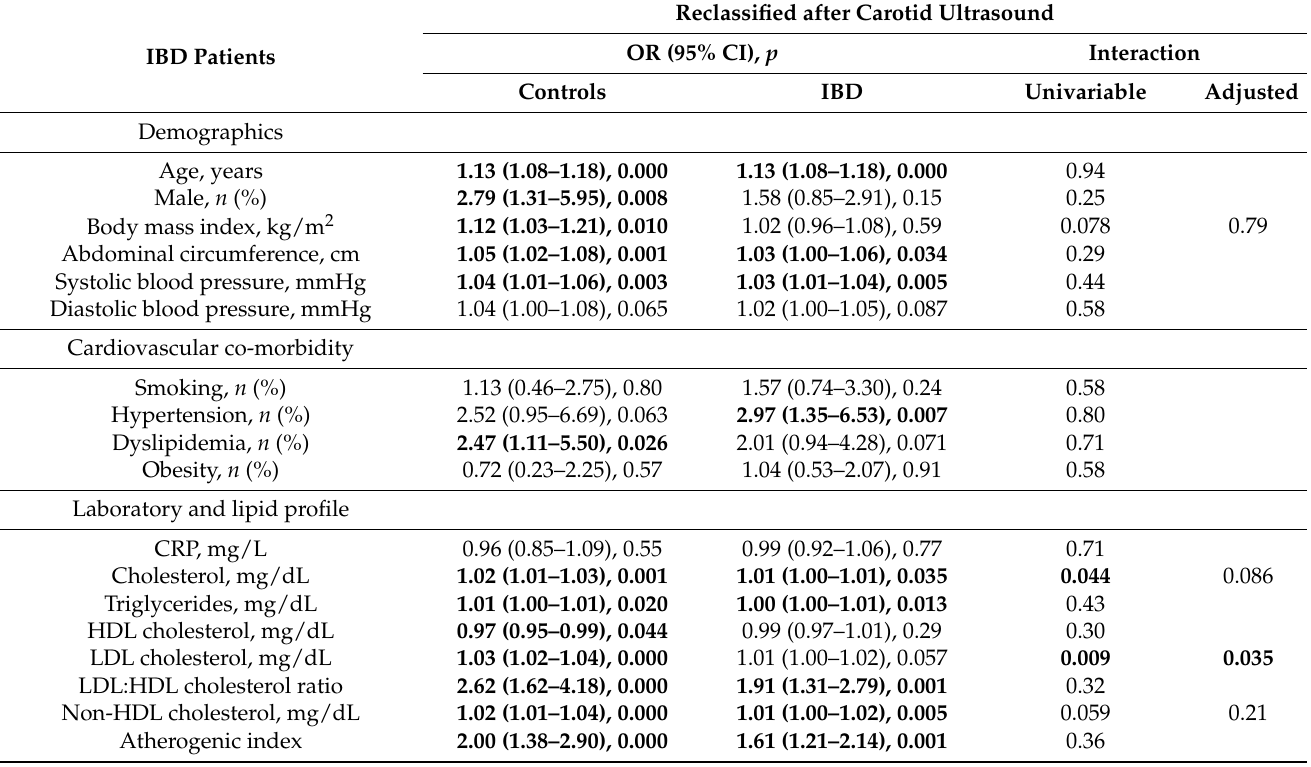
Table 3. Differences in the effect of traditional cardiovascular risk factors on reclassification in IBD patients and